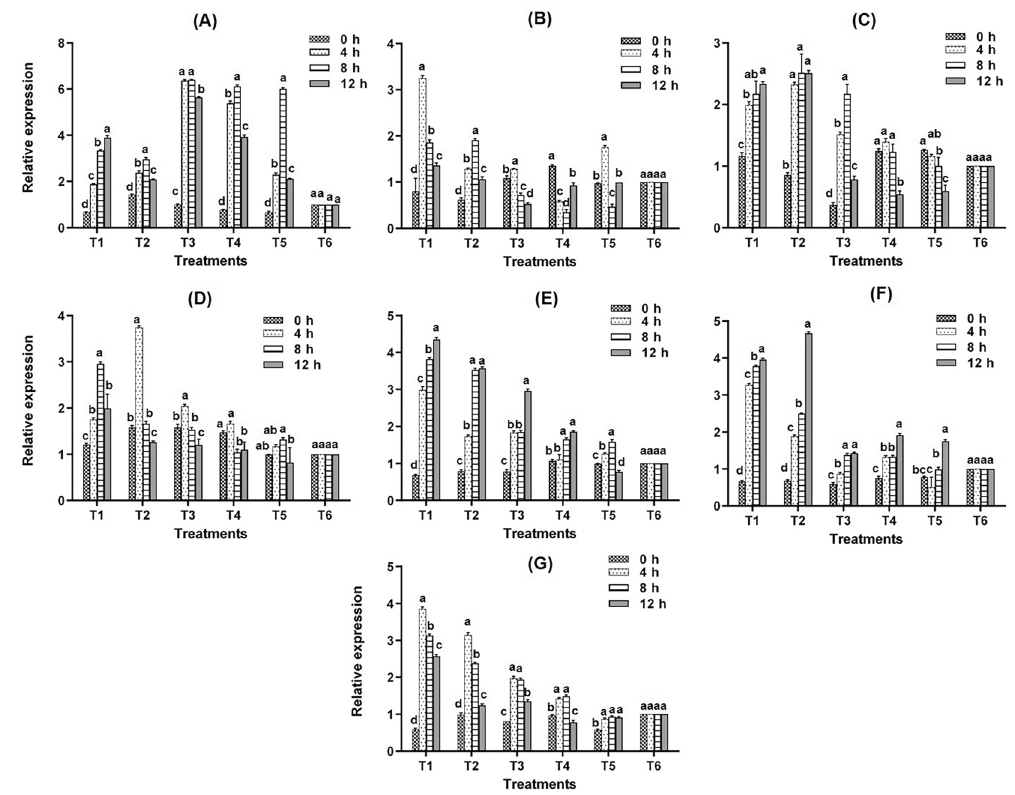
Figure 7. Response of ( A ) APX, ( B ) E2F, ( C ) HSFA2A, ( D ) HSFB2B, ( E ) HSFB4C, ( F ) HSFC1A and ( G ) OsZIP-12 to fungicidal stress in different treatments